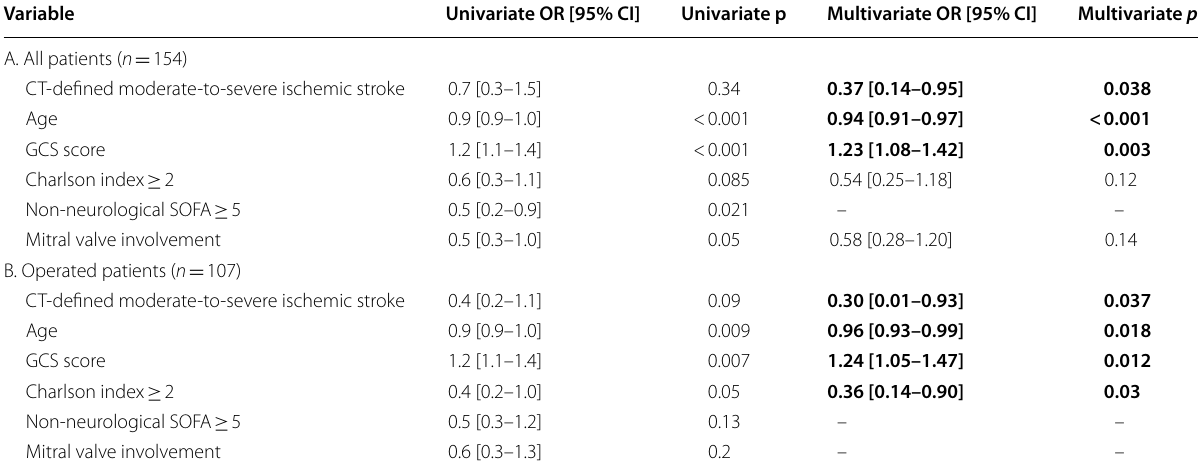
A separate regression analysis was performed for each baseline brain CT category. Minor ischemic stroke, cerebral hemorrhage and normal CT were not significantly associated with 1-year favorable outcome neither in the principal analysis, nor in the operated population. Mitral valve involvement, non-neurological SOFA charlson comorbidity index (whole population only) were not retained for the final model during the backward selection procedure ( p > 0.2). Variables significantly associated with outcome in multivariable analysis ( p < 0.05) are displayed in bold CT computed tomography, GCS Glasgow Coma Scale, SOFA Sequential Organ Failure